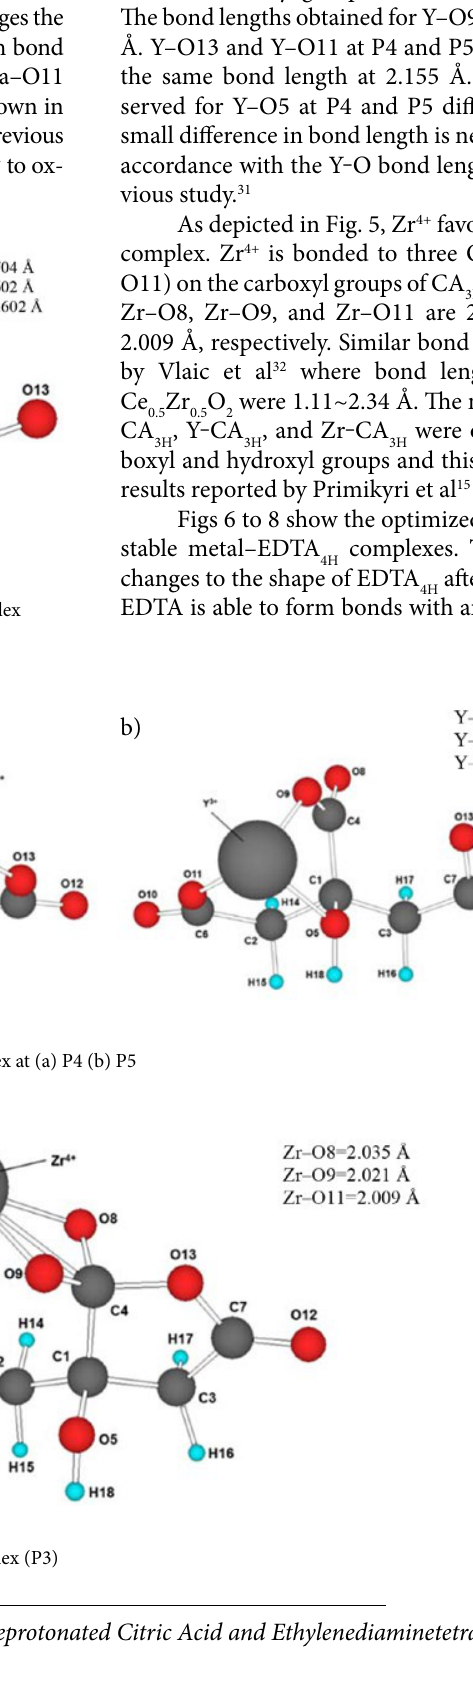
Fig. 5. Optimized structure of the most stable Zr–CA